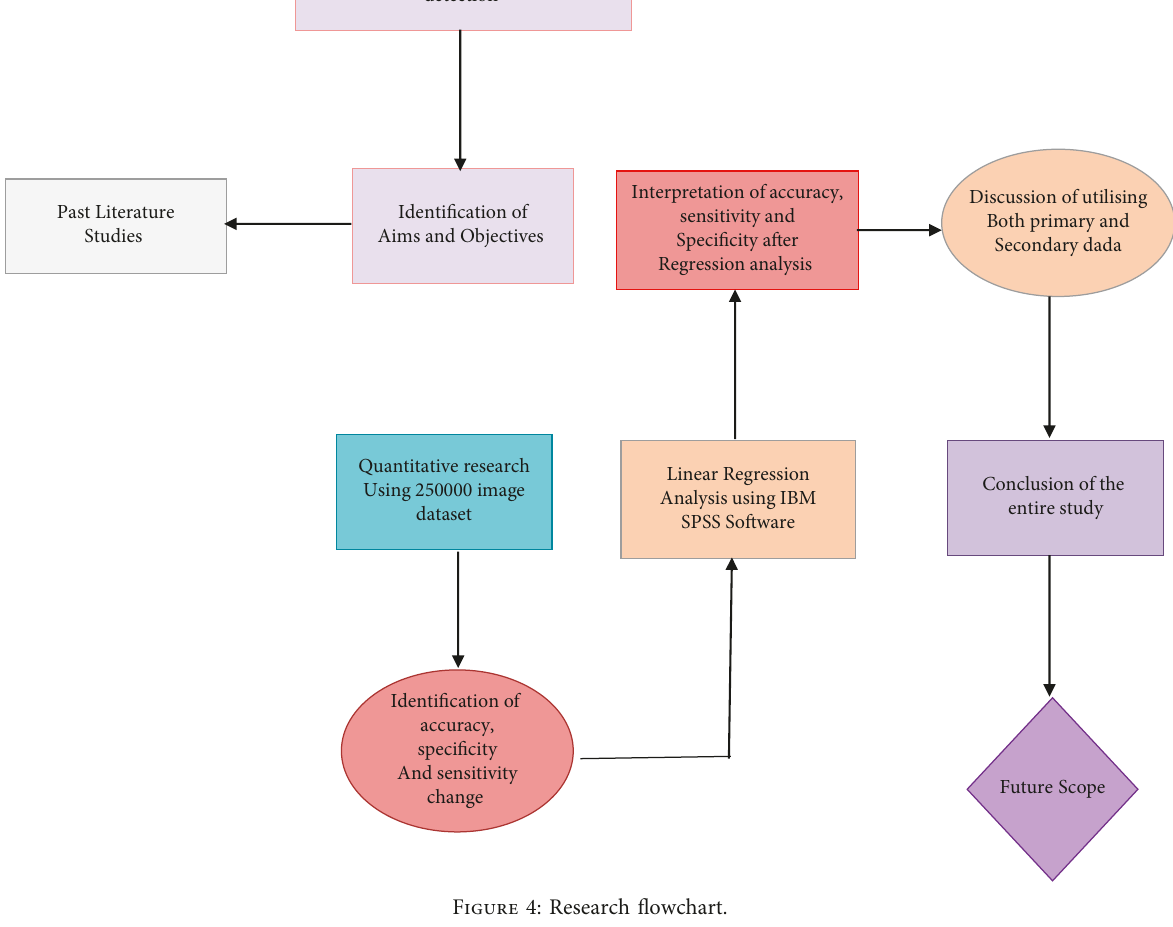
Figure 4: Research flowchart. Table 1: Descriptive statistics showing frequencies of